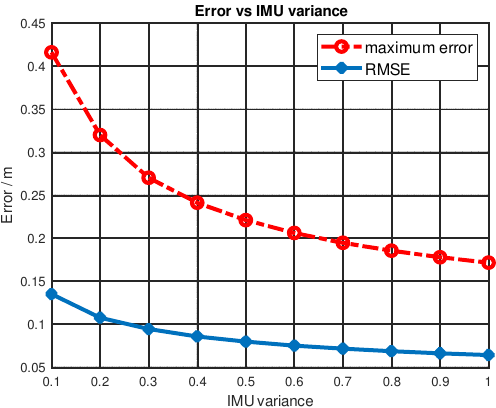
Figure 9. Maximum error and RMSE vs. IMU variance.